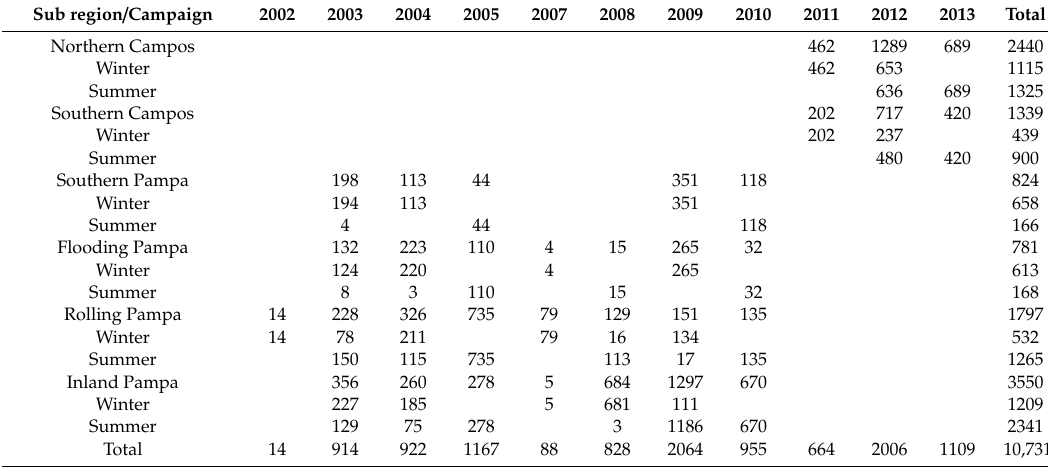
Figure 3. Location of the field data in the study area. Table 1. Number of paddocks considered in the Phenological Library for each subregion, year and agricultural campaign; totals by sub region and general totals are highlighted in